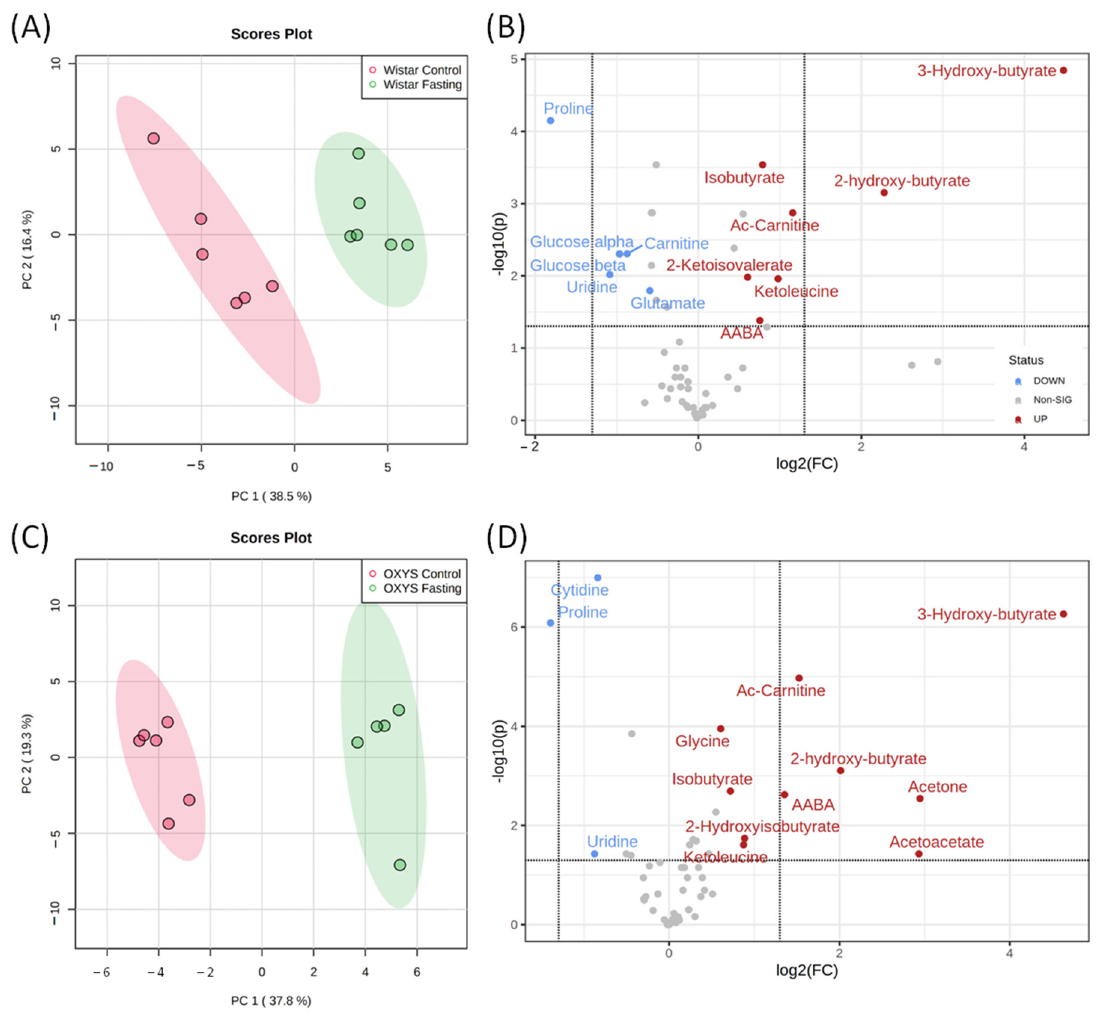
Figure 3. PCA score plots and Volcano plots of blood metabolites of Wistar ( A , B ) and OXYS ( C , D ) rat strains for fasting and control groups. In Volcano plots, the horizontal line depicts a cut-off of FDR-adjusted p -value = 0.05; metabolites with fold change threshold (fasting vs. control) = 1.5 are highlighted.